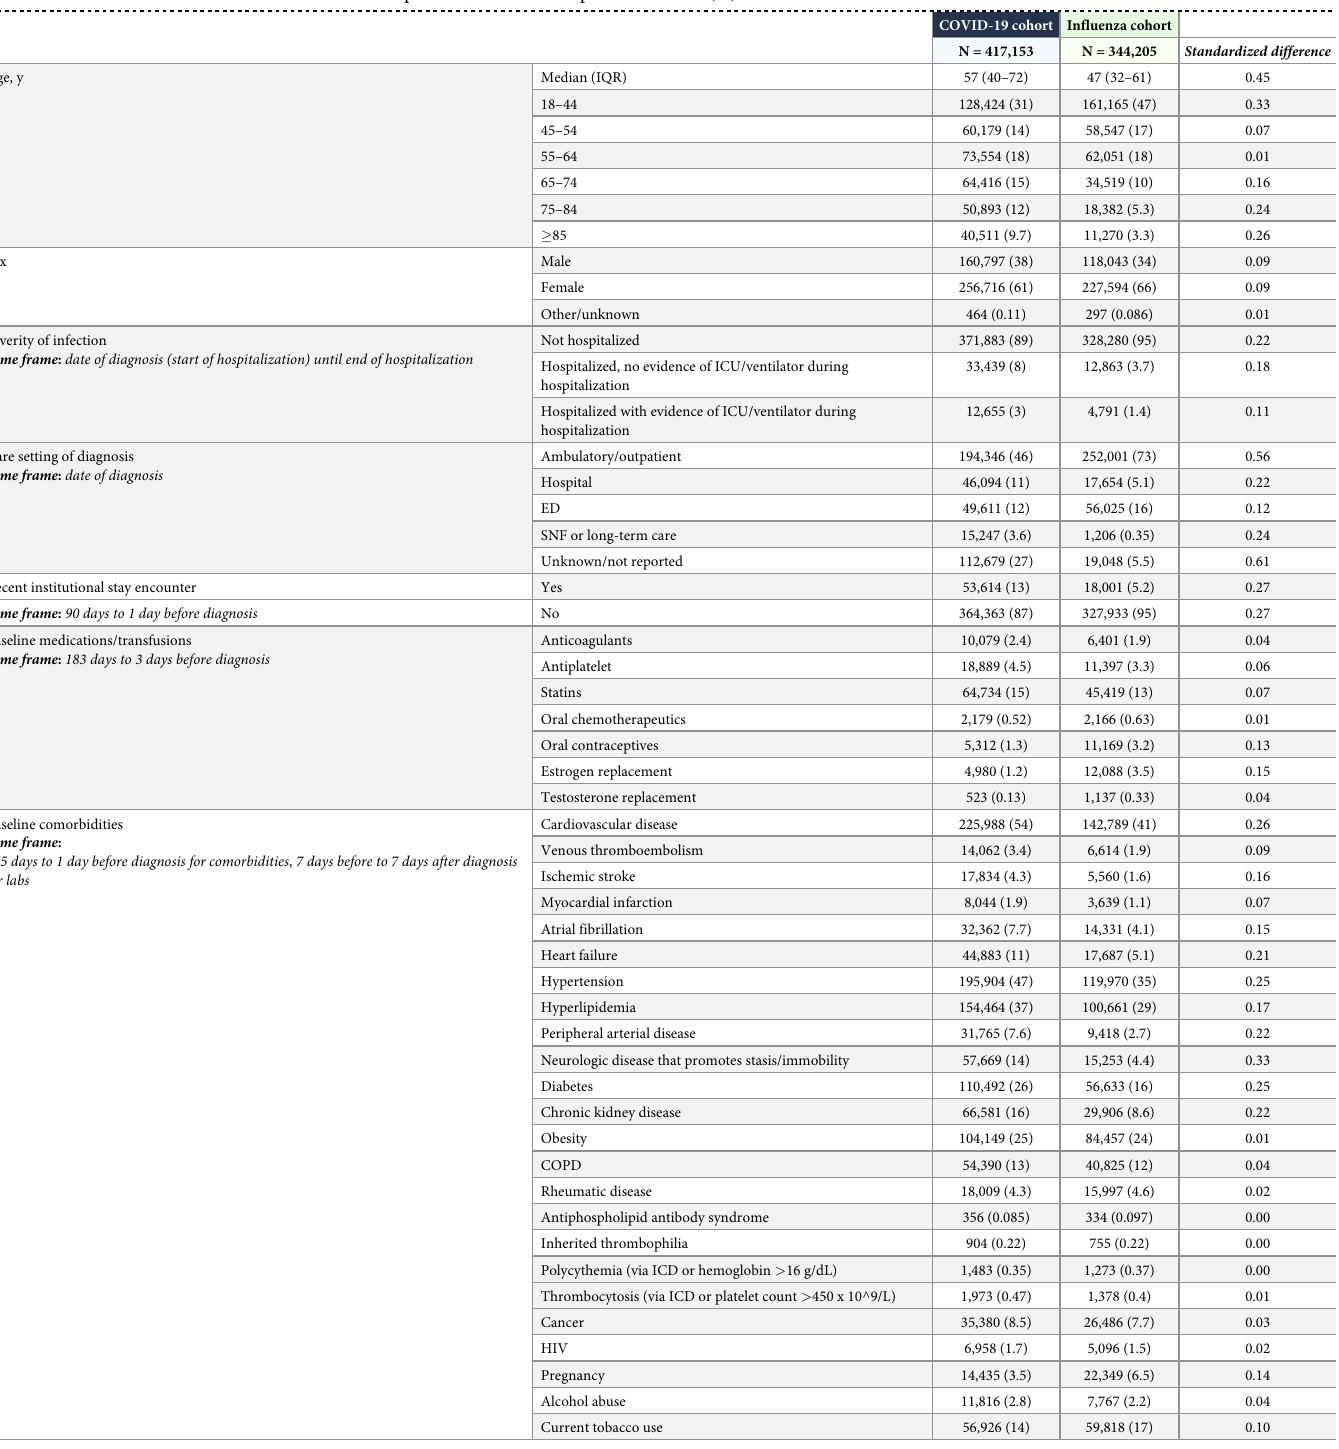
Table 1. Patient characteristics. Unless otherwise specified, all values are presented as “N